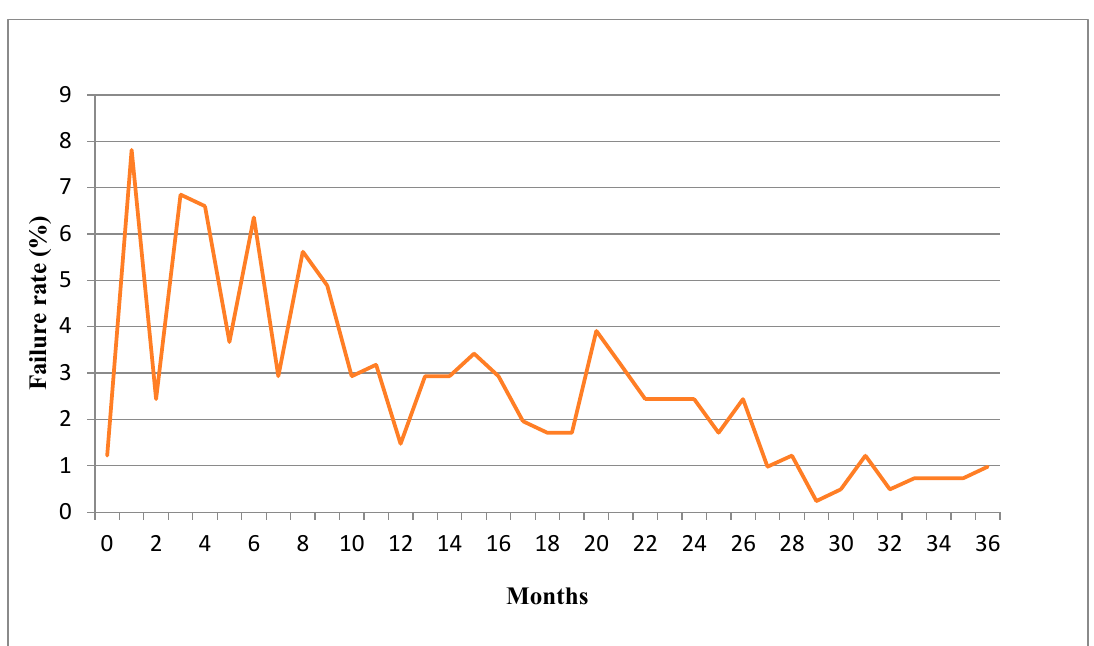
Figure 3. Bracket failure rates in different stages of orthodontic treatment.